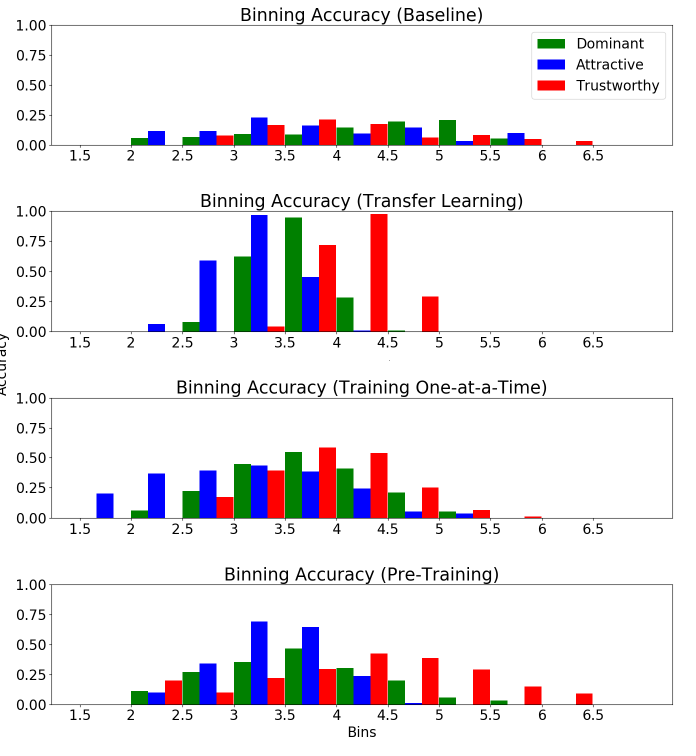
Figure 8. Average binning accuracy over 5 splits for each regression